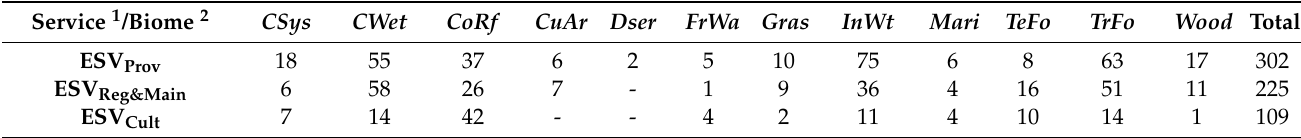
Table 1. Number of valuation studies, by service and biome, from the ESVD included.